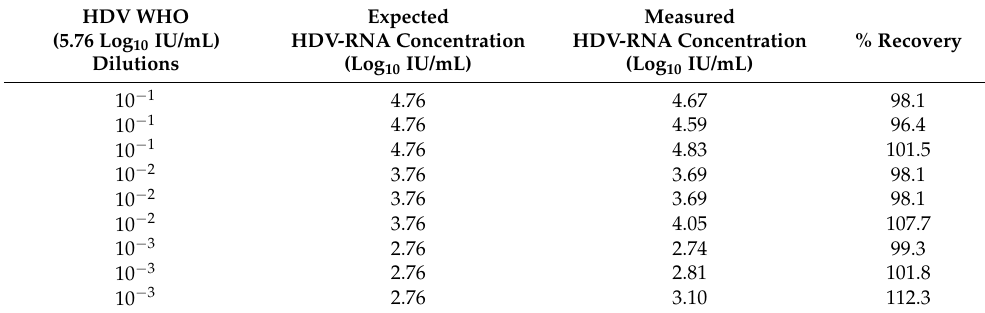
Table 2. ddPCR accuracy of recovery.